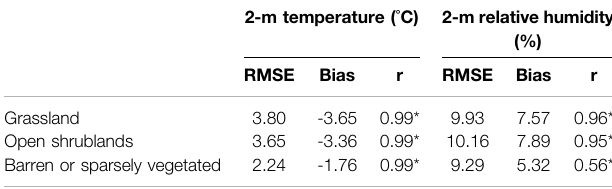
TABLE 2 | Root-mean-square error (RMSE), bias and correlation coef fi cient (r) of the daily averaged value of2-m temperature ( ° C) and 2-m relative humidity (%) between observations and High-Resolution Assimilation Dataset of the Water- Energy Cycle in China simulated results over Qinghai-Tibet Plateau, * indicates result passed the signi fi cance level t-test of α (cid:2) 0.01.